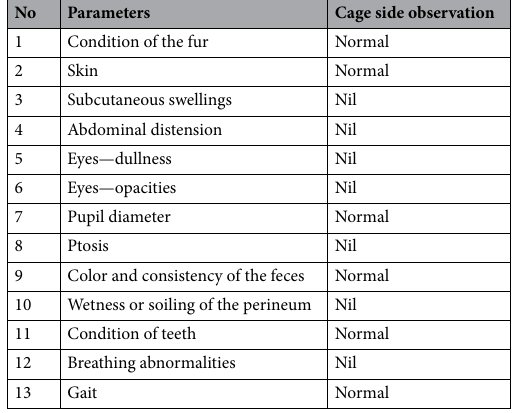
Table 2. Cage-side observations for all animals’ parameters cage-side